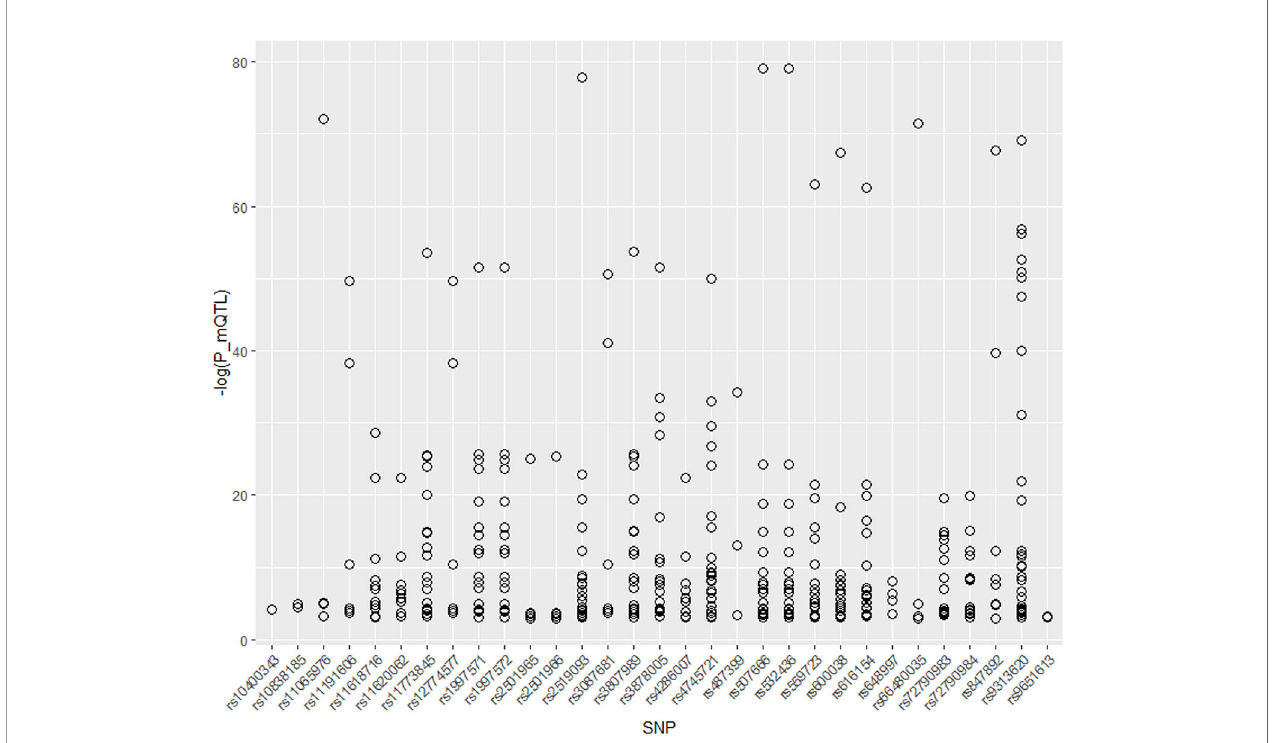
FIGURE 3 | P value of 31 signi fi cant SNPs in